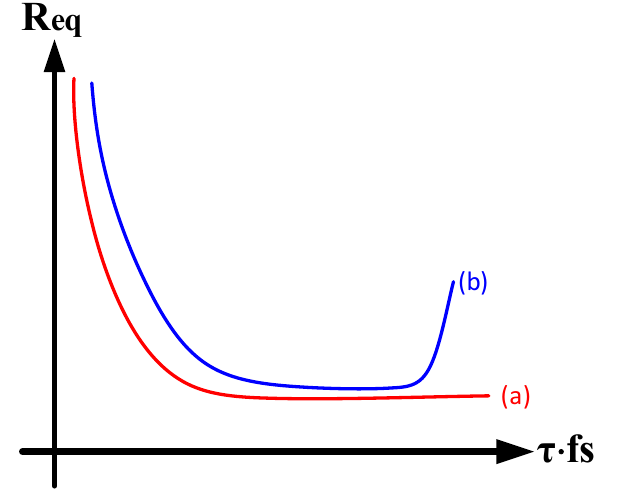
Figure 20. Behavior of the converter equivalent resistance as a function of the time constant and switching frequency: ( a ) ideal model; ( b ) real model.